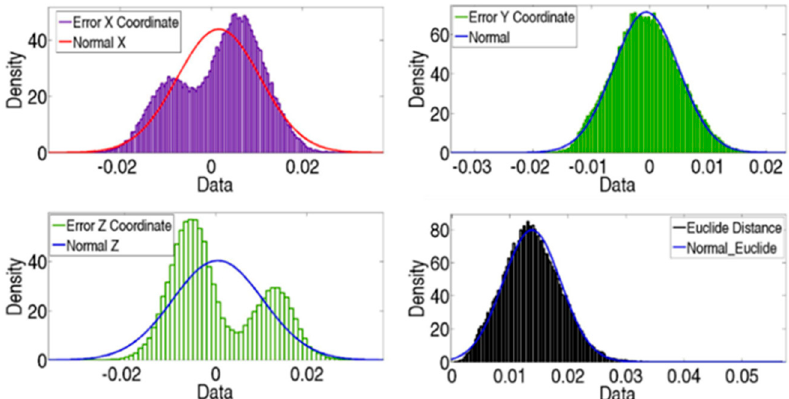
Figure 14. Final error of MT verification points of 1000 tests in total.